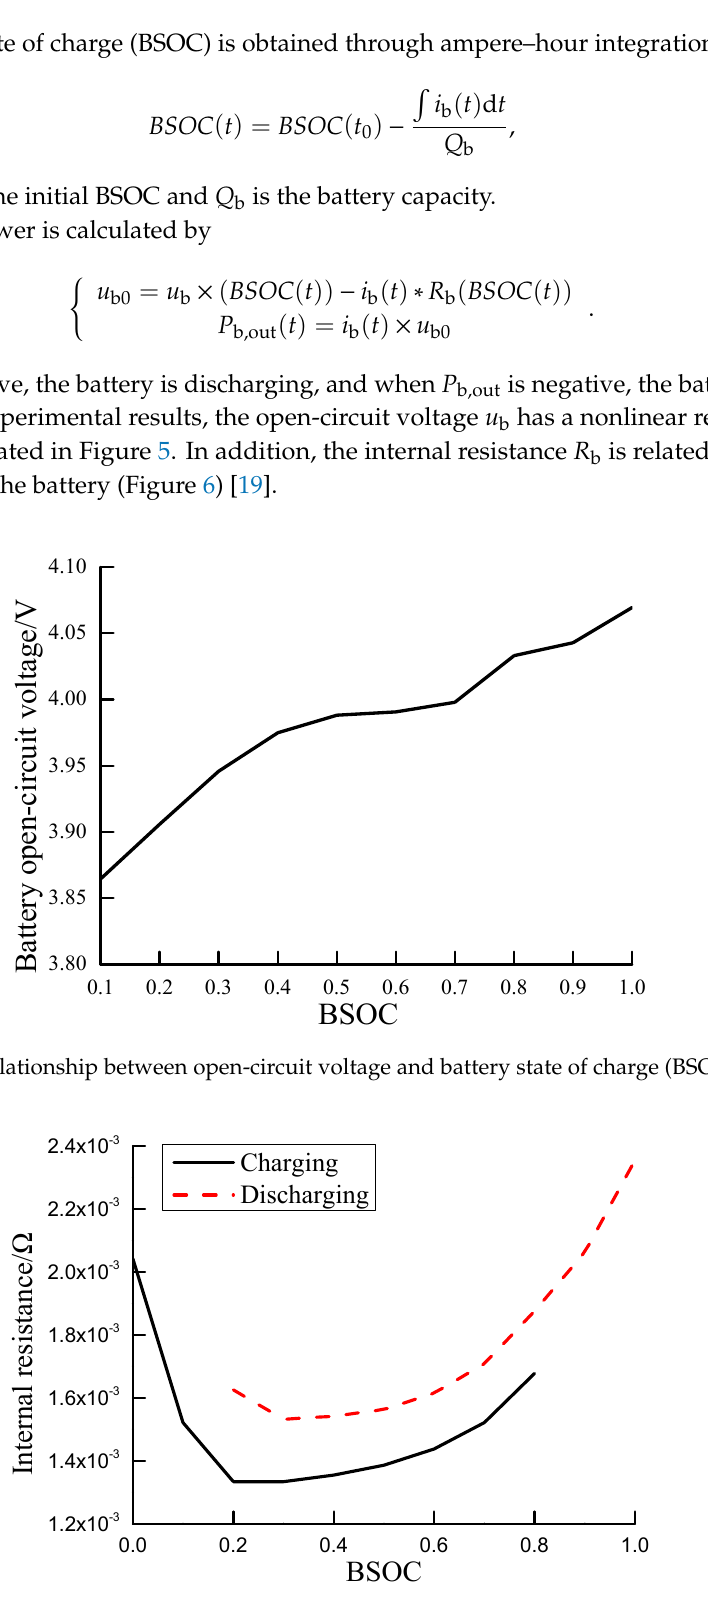
Figure 4. Equivalent model of the single-battery model [19].